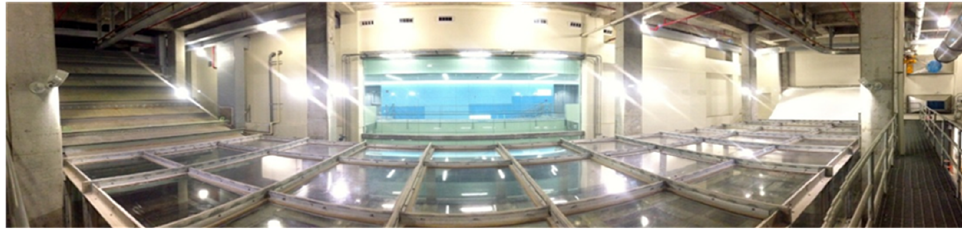
Figure 1. The Surge Structure Atmosphere Interaction (SUSTAIN) facility at the University of Mi- ami.